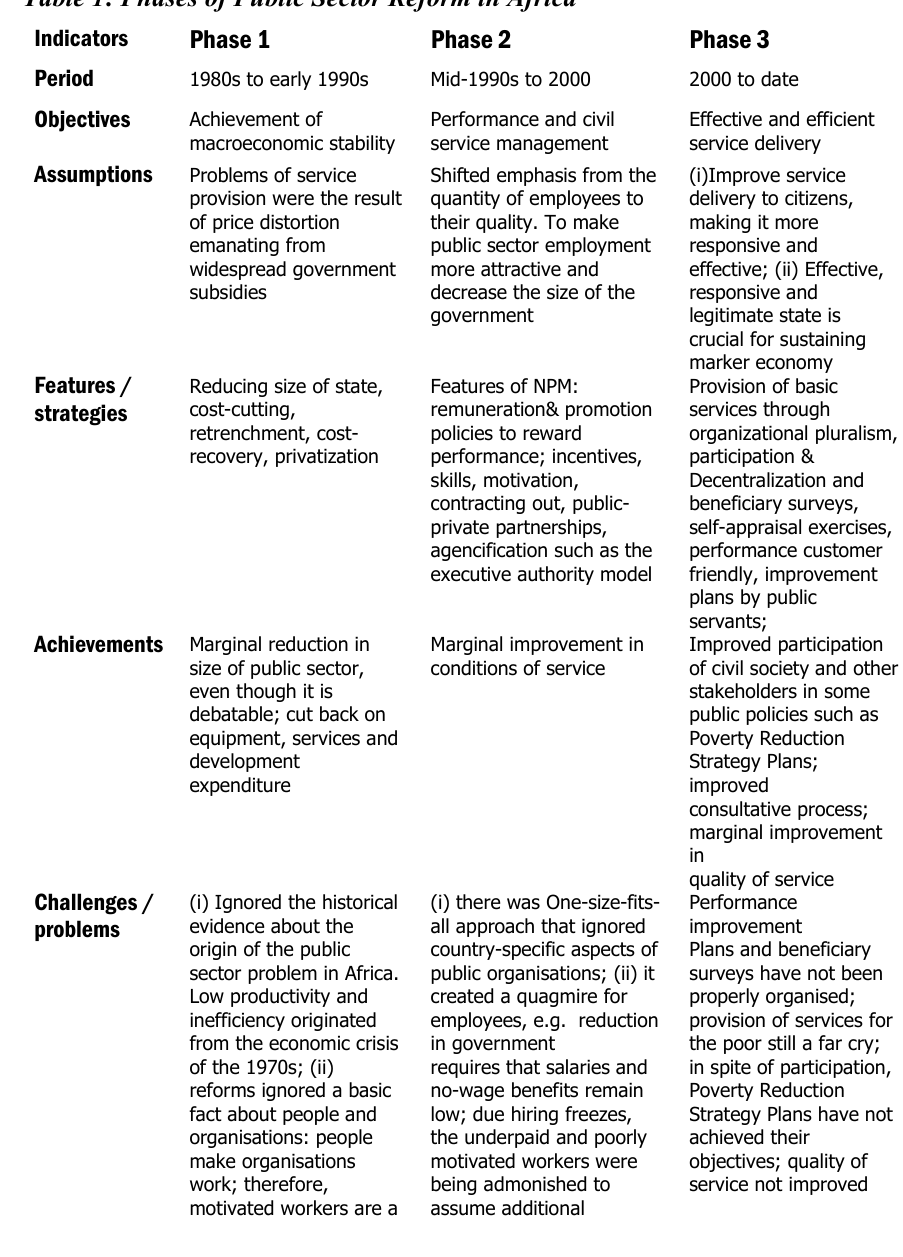
Table 1: Phases of Public Sector Reform in Africa